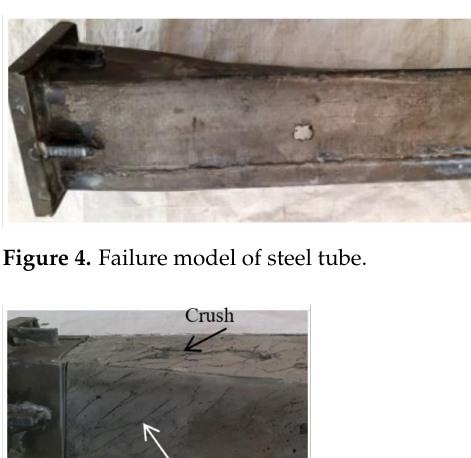
Figure 3. Failure model of CFRP. ( a ) SBT111 specimen. ( b ) SBT211 specimen.